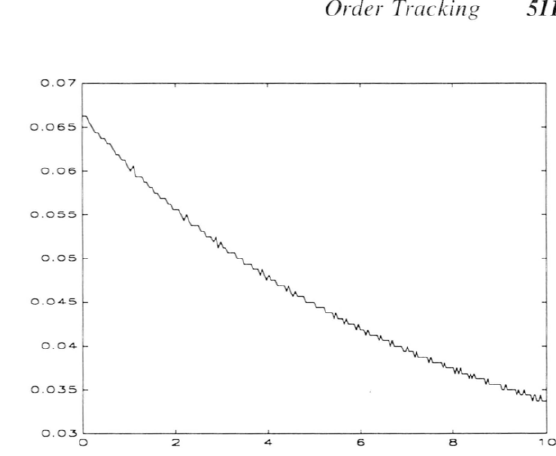
FIGURE 4 Period estimate with fine sampling (LlIIS).